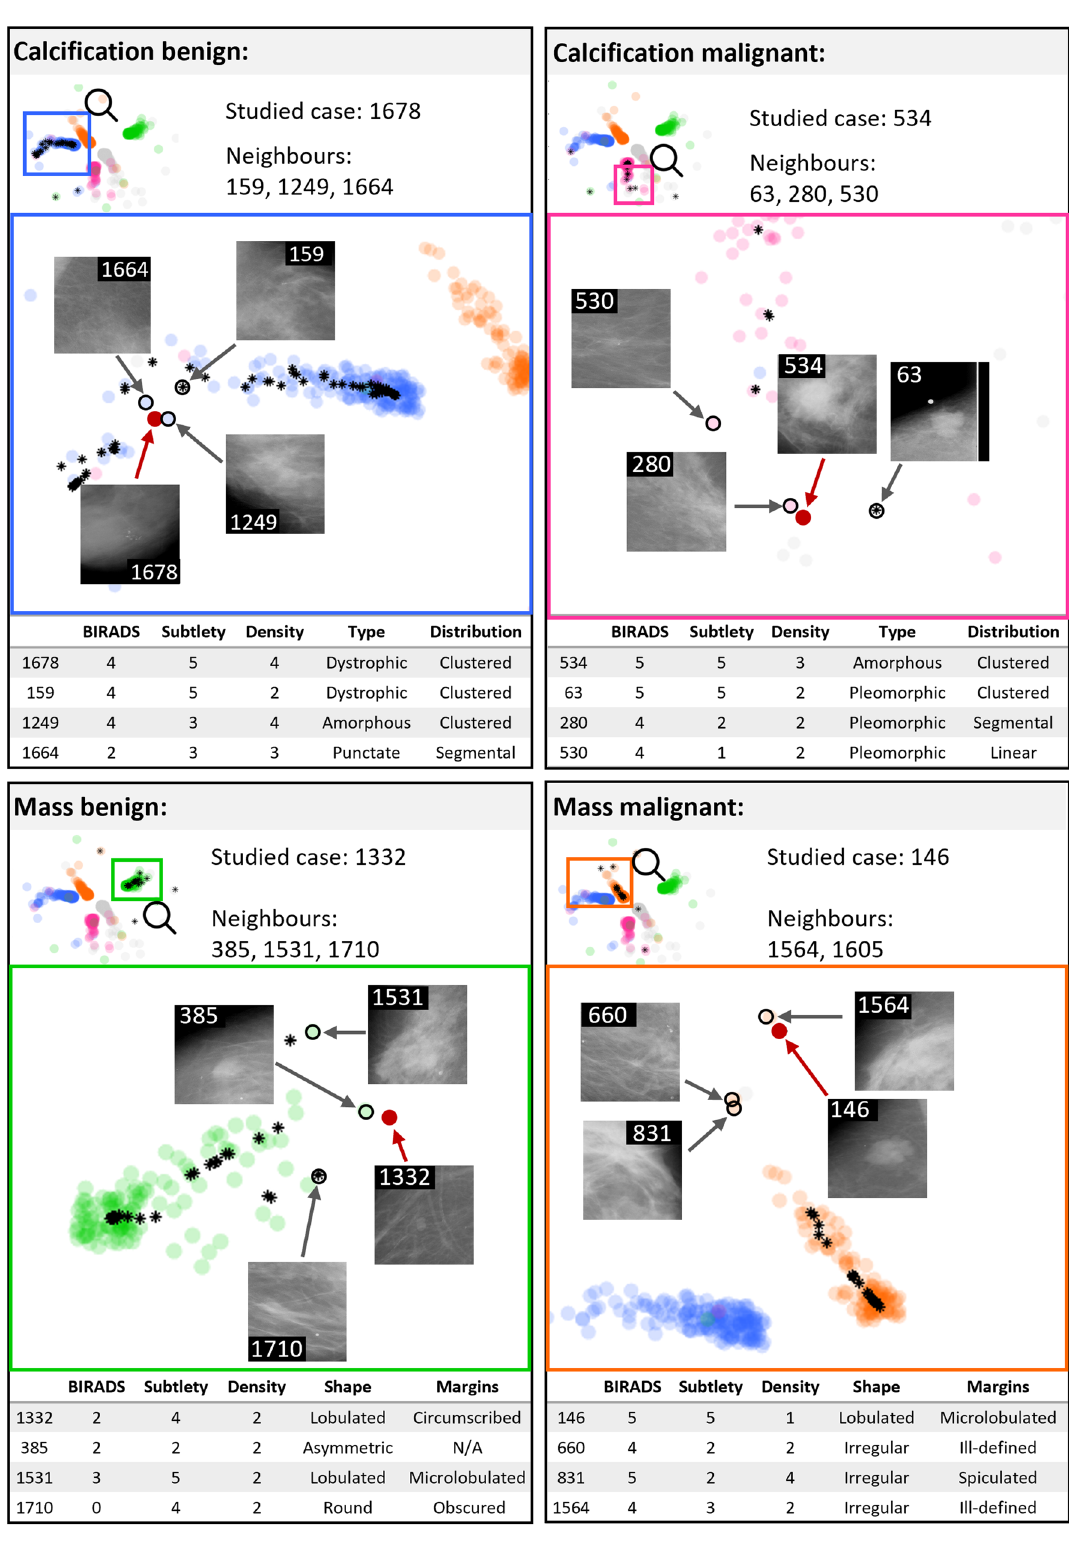
Figure 6. ‘Patient like me’ analysis of four selected cases that were correctly classified. Top left: patient 1678 (calcification benign); top right: patient 534 (calcification malignant); bottom left: patient 1332 (mass benign); and bottom right: patient 146 (mass malignant).. Cases are represented by points with added transparency as in Fig. 5. Black stars are the correctly classified test cases in each of the four groups, and the selected cases are represented with solid red circles. Neighbouring cases were also selected and visualised (empty black circles) for each of the four previous